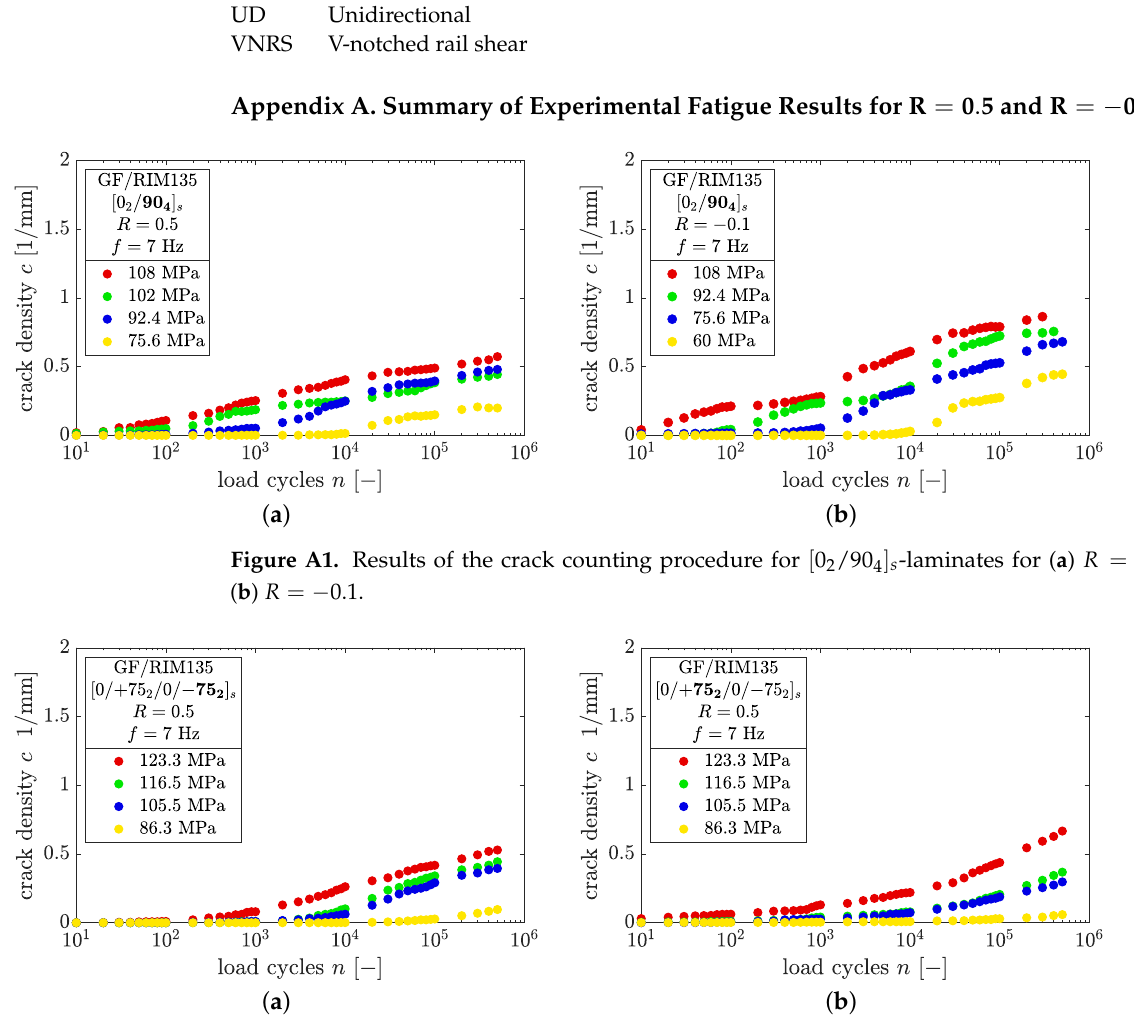
Figure A2. Results of the crack counting procedure for [ 0/ + 75 2 /0/ − 75 2 ] s -laminates for ( a ) thick and ( b ) thin layers at R = 0.5.